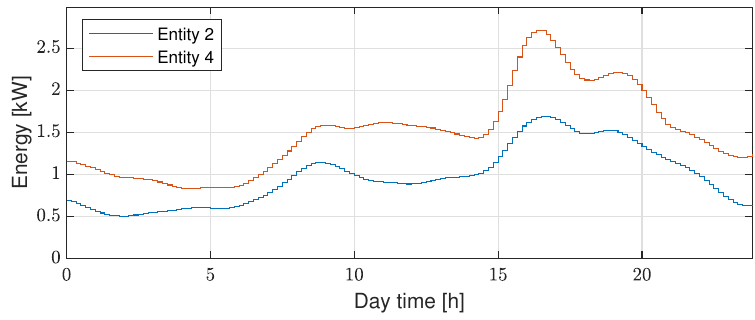
Figure 5. Example 3. Non-flexible energy demand profiles in day 10.